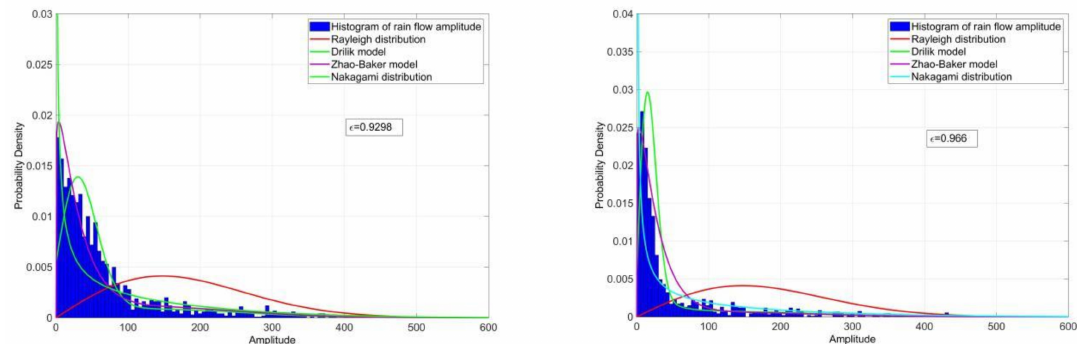
Figure A5. Probability density distribution of rain flow amplitude (multi-peak spectrum).